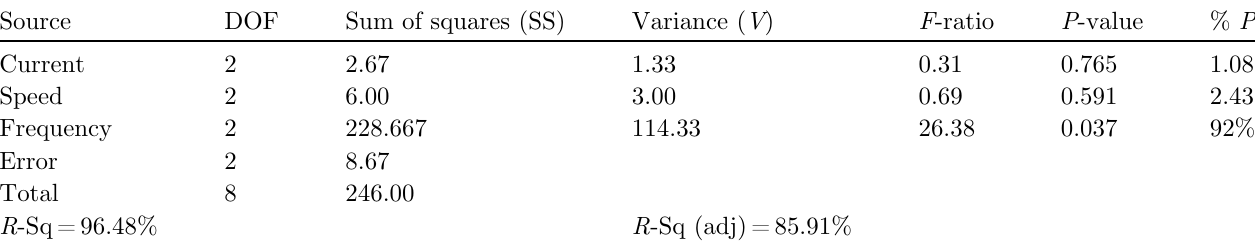
Table 9. Response table for S/N ratio of UTS of L